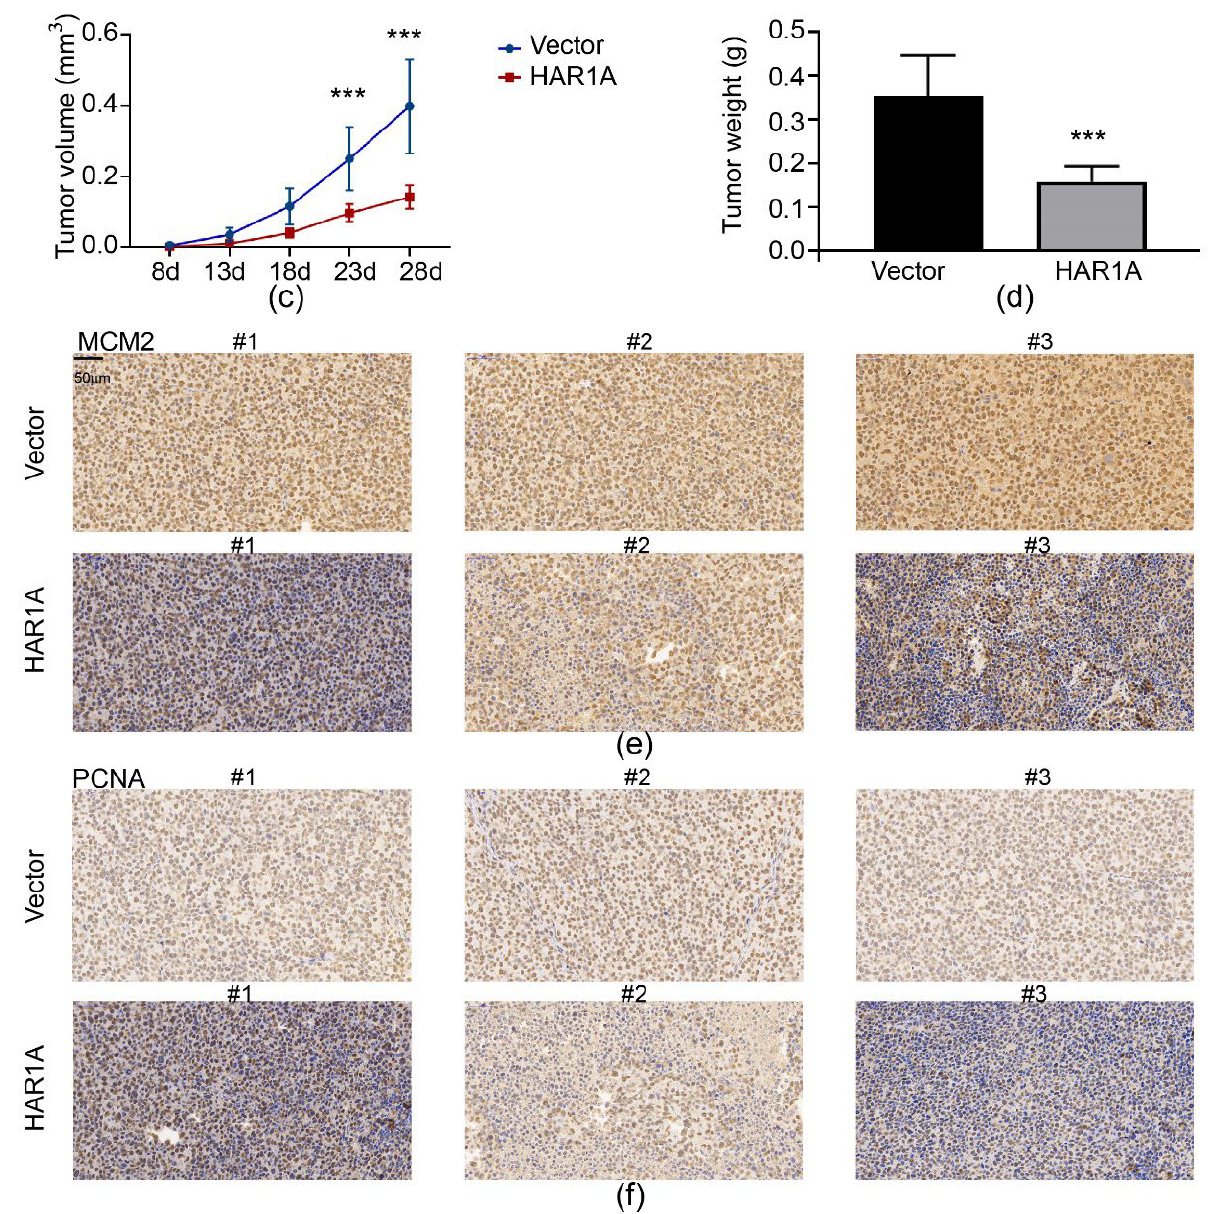
Figure 8. Tumor-suppressing effects of lncRNA HAR1A on NSCLC in vivo. ( a ) Images of tumors in nude mice generated from A549 cells transfected with LV-NC and LV- HAR1A . ( b ) qRT-PCR analysis of lncRNA HAR1A levels in two groups of nude mice. Comparison of tumor volumes ( c ) and tumor weights ( d ) between LV-NC and LV- HAR1A groups (n = 6). ( e ) Immunohistochemical staining of MCM2 on tumors for LV-NC and LV- HAR1A groups (n = 3). ( f ) Immunohistochemical staining of PCNA on tumors for LV-NC and LV- HAR1A groups, *** p <